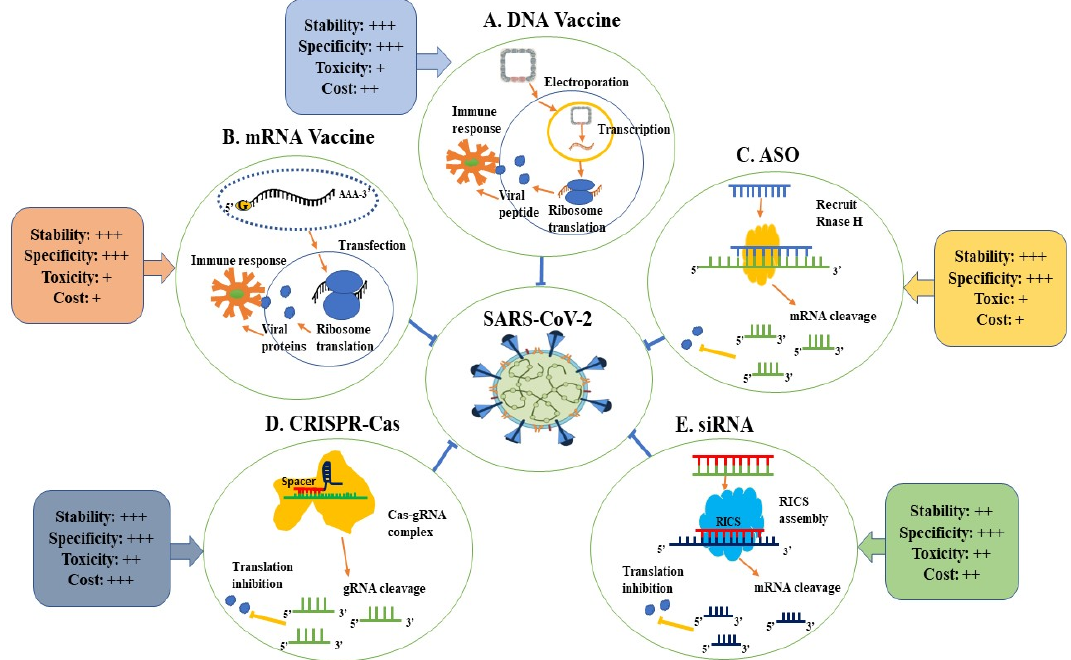
Figure 3. Applications of therapeutic nucleic acids in the fight against SARS-CoV-2. ( A ) DNA vaccine: The SARS-CoV-2 S protein is contained within a circle of DNA, which serves as a DNA vaccine. Following electroporation, the permeation of the cell membrane will be increased, allowing DNA to enter the cytoplasm and so reach the nucleus more easily. Following then, DNA will be transcribed into mRNA, which will be further translated into the SARS-CoV-2 S protein and expressed on the cell membrane. ( B ) mRNA vaccine: The cytoplasmic integration of nanoparticle-encapsulated mRNA expressing the SARS-CoV-2 antigen will take place. The S protein mRNA utilizes the ribosome and bases to translate S proteins, which are expressed on the cell membrane. Immune cells will recognize the membrane S protein, which will result in the activation of an immune response. ( C ) ASO: ASO attaches to the complementary sequence of an mRNA in the nucleus. Following an RNA–DNA hybrid, which becomes a substrate for RNase H, the complementary base pairing between ASO and mRNA results in endonuclease-mediated transcript suppression. The transport of mRNA into the cytoplasm is inhibited, blocking protein synthesis. ( D ) CRISPR–Cas: Upon entering the cell, the Cas protein and the gRNA are both expressed, and the Cas protein and the gRNA form a complex with one another. In this way, the spacer region serves as a guide for the Cas effector by matching to complementary sequences in the viral genome, allowing the associated Cas effector to cleave the viral RNA and disrupt viral functions. ( E ) siRNA: The RISC recognizes and loads the siRNAs, which then separates two strands of associated siRNAs and releases the sense strands. In addition, the antisense strand associated with the RISC directs the complex to the target matching RNA sequences, which could host cellular transcripts or viral RNAs, ultimately leading to RNA degradation mediated by the RISC enzyme. As a result, these siRNAs have the potential to downregulate the expression of the target host/viral genes that are critical for viral activity and to disrupt viral replication and transcription [152,156–159]. One plus (+) indicates the lowest level, while three pluses (+++) indicate the highest level; these data were compiled from several articles [152,156–159]. Abbreviation: CRISPR, Clustered Regularly Interspaced Short Palindromic Repeats; Cas, CRISPR-associated; ASO, antisense oligonucleotides; RISC, RNA-induced silencing complexes; siRNA, small interfering RNA; gRNA, guide